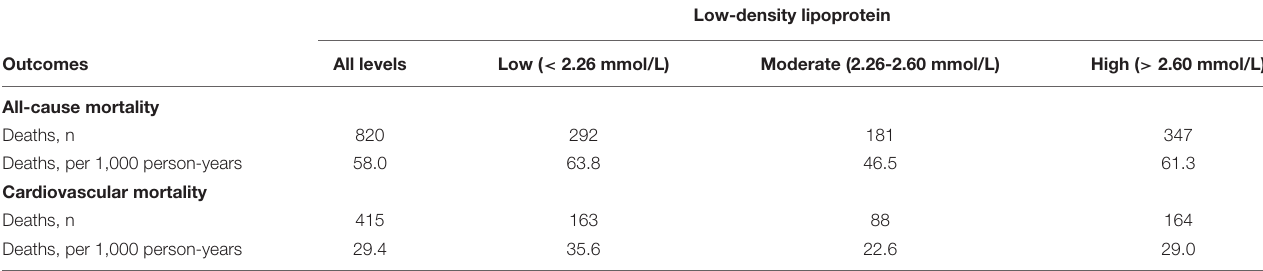
TABLE 2 | Incidence rate of death according to low-density lipoprotein cholesterol.